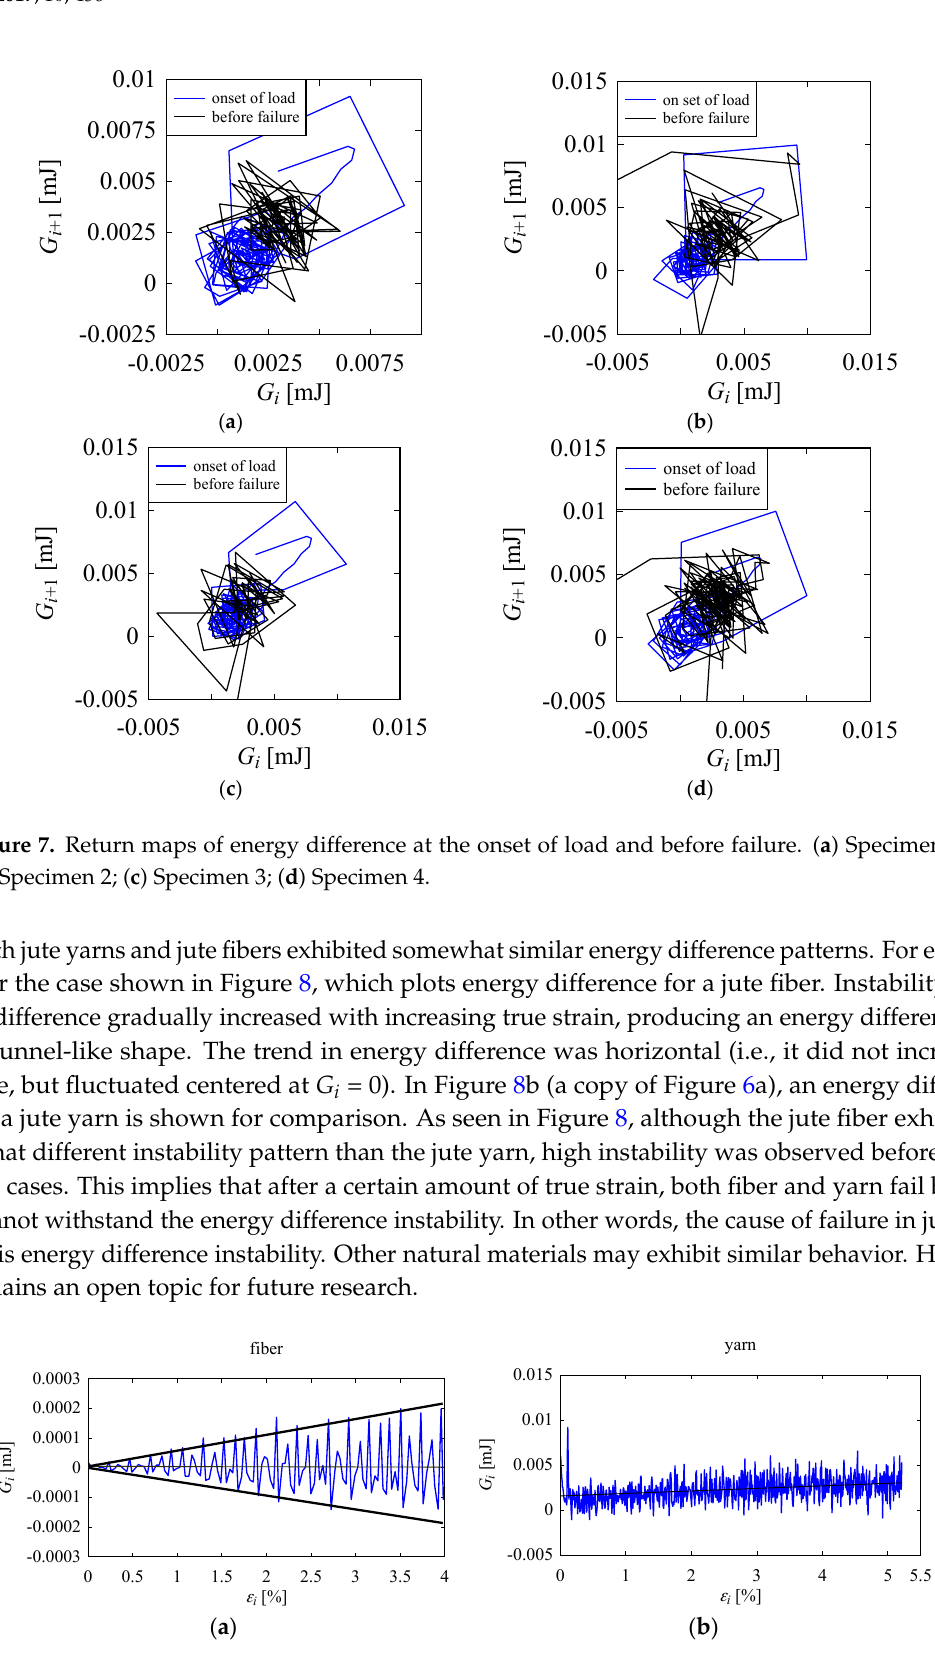
Figure 8. Comparison between ( a ) jute fiber and ( b ) jute yarn (copy of Figure 6a) in terms of energy difference.